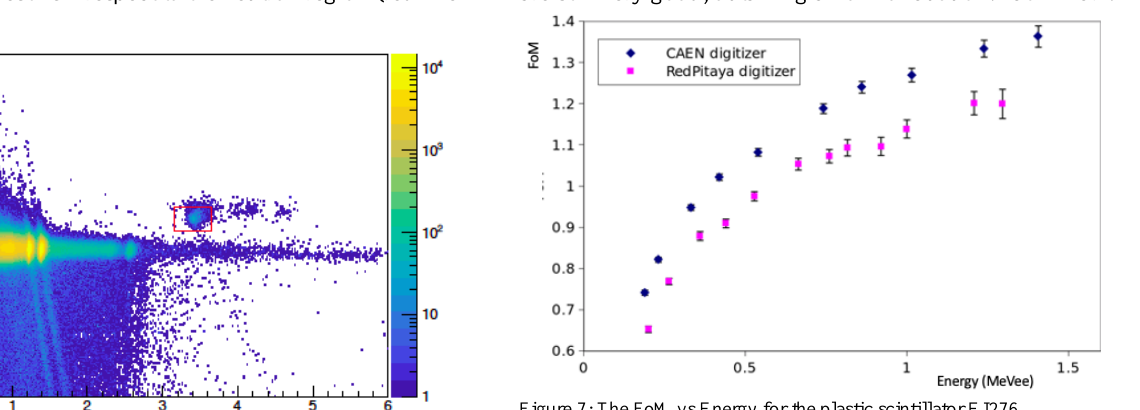
Figure 7: The FoM vs Energy for the plastic scintillator EJ276.